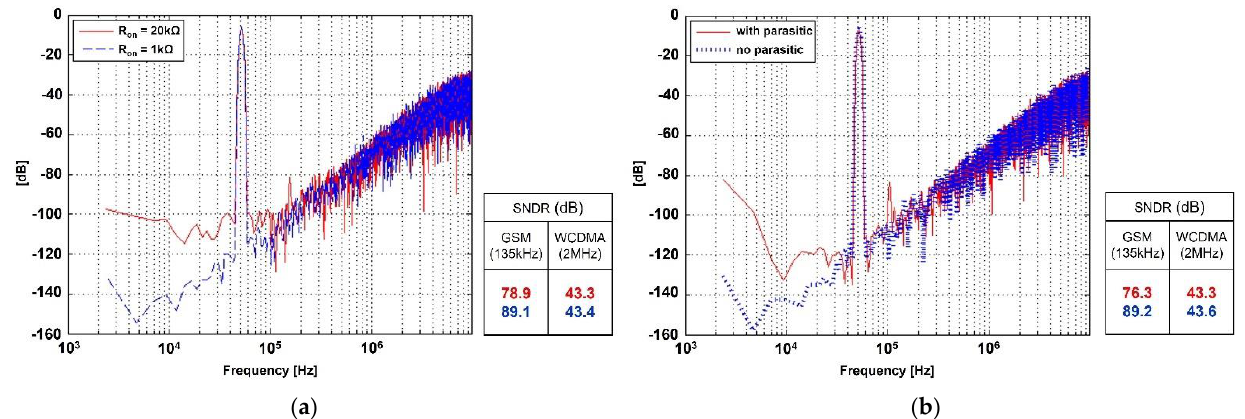
Figure 11. Modulator output spectrum with SC integrator non-ideality. ( a ) Switch-on resistance ( b ) Parasitic capacitance.